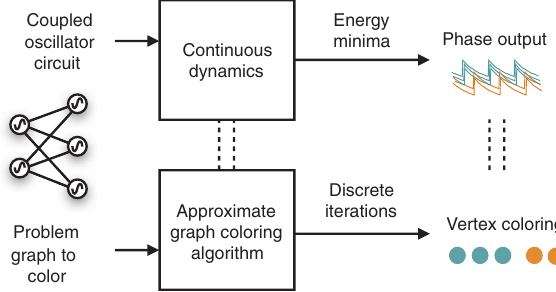
Figure 7: Overview of the proposed graph coloring system using coupled VO oscillators where each node corresponds to a VO 2 oscillator. The dynamics of the system corresponds to an approxi- mate graph coloring algorithm, and as such, the steady-state phase output of the VO oscillators can be used to color the nodes of the 2